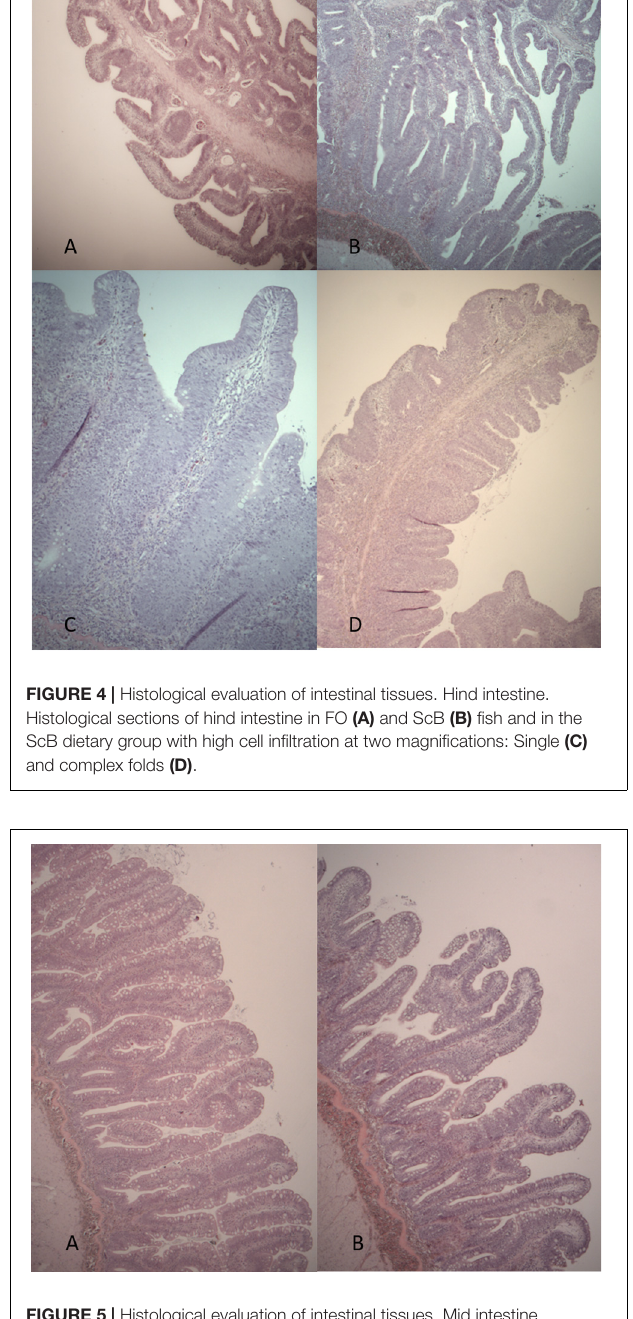
potential relation between omega-3-fatty acids, zinc transporter levels, and free zinc availability in cell level (review from De Mel and Suphioglu,